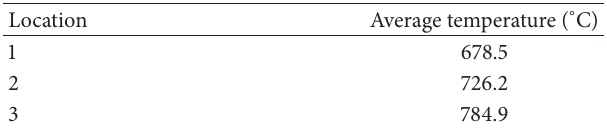
Table 1: The average temperature of locations 1, 2, and 3 within 150 hours.